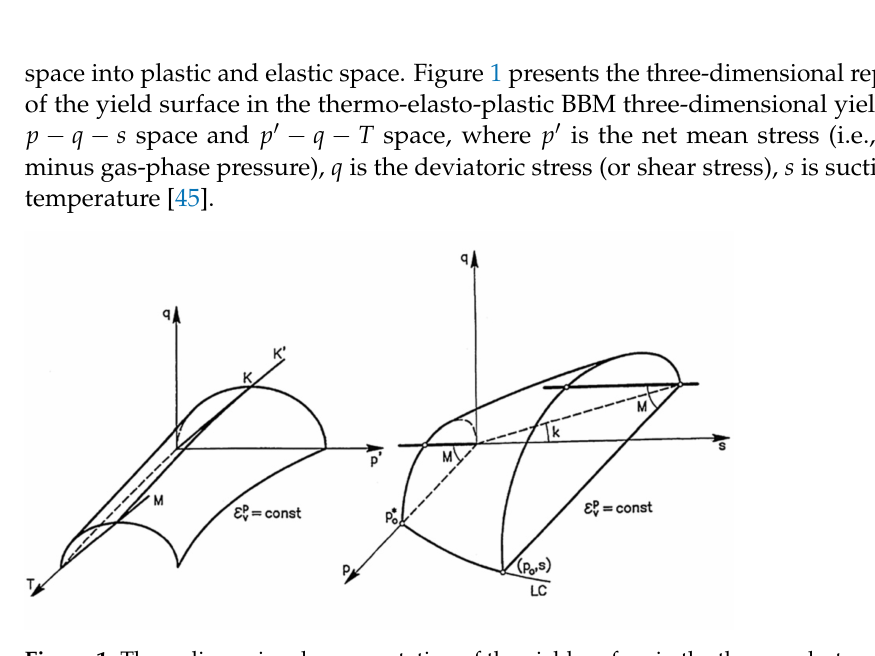
Figure 1. Three-dimensional representation of the yield surface in the thermo-elasto-plastic